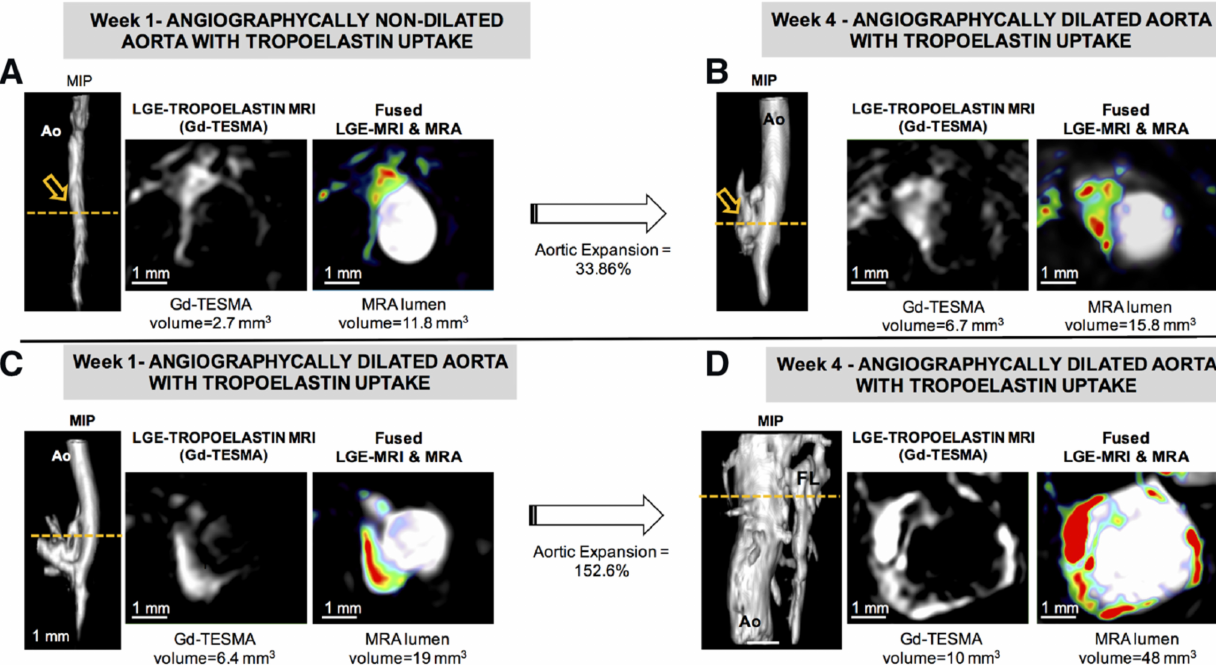
Figure 2. Gd-TESMA MRI shows increased tropoelastin expression in the dilated aortic segments ( C , D ). ( A – D ) MRA and late gadolinium enhancement (LGE)-MRI of a control ( A , B ) and an Ang II-infused ApoE-/- mouse with aortic dilatation ( C , D ) scanned with the tropoelastin contrast agent. Fusion of MRA and LGE-MRI images of an Ang II-infused ApoE-/- mouse after administration of Gd-TESMA show that the uptake of tropoelastin is restricted to the dilated aortic wall. Abbreviations: Ao, aorta; LRA: left renal artery; MIP, maximum intensity projection; RRA, right renal artery. Adapted from: Lavin et al., [29] (open access article, distributed under the terms of the Creative Commons Attribution